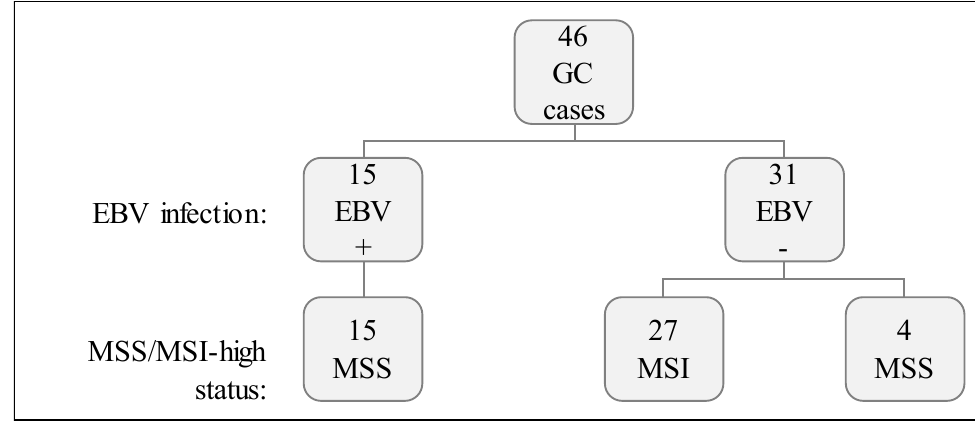
Figure 1. Cohort characterization for EBV infection and MSI status.